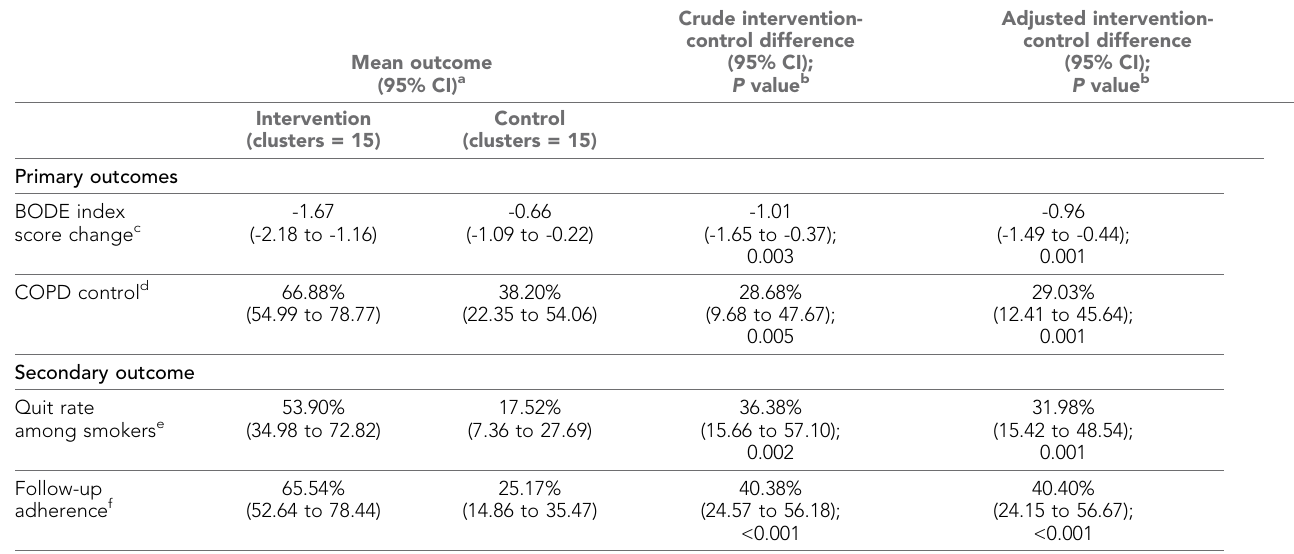
Table 2. Primary and secondary